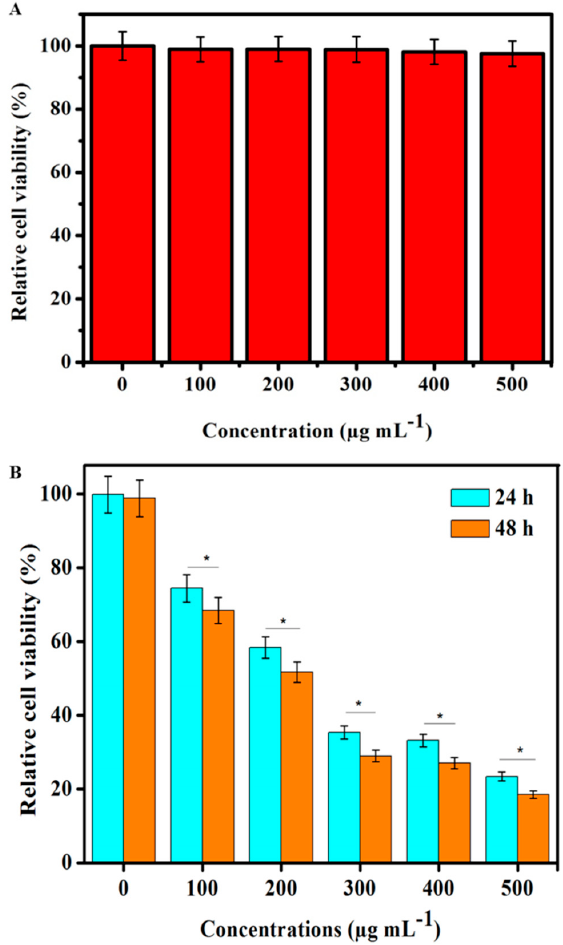
Figure 4. MBA-MD-231 cell viability ( A ) Biocompatibility of c-phycocyanin with MBA-MD-231 cells; and ( B ) different concentrations of c-phycocyanin-treated MBA-MD-231 cells showed cytotoxicity after PDT treatment using a 625-nm laser at 80 mW·cm − 2 for 30 min. Data is expressed as mean ± SD of the three experiments. Percentage of cytotoxicity is expressed relative to untreated controls (* significant p < 0.05).